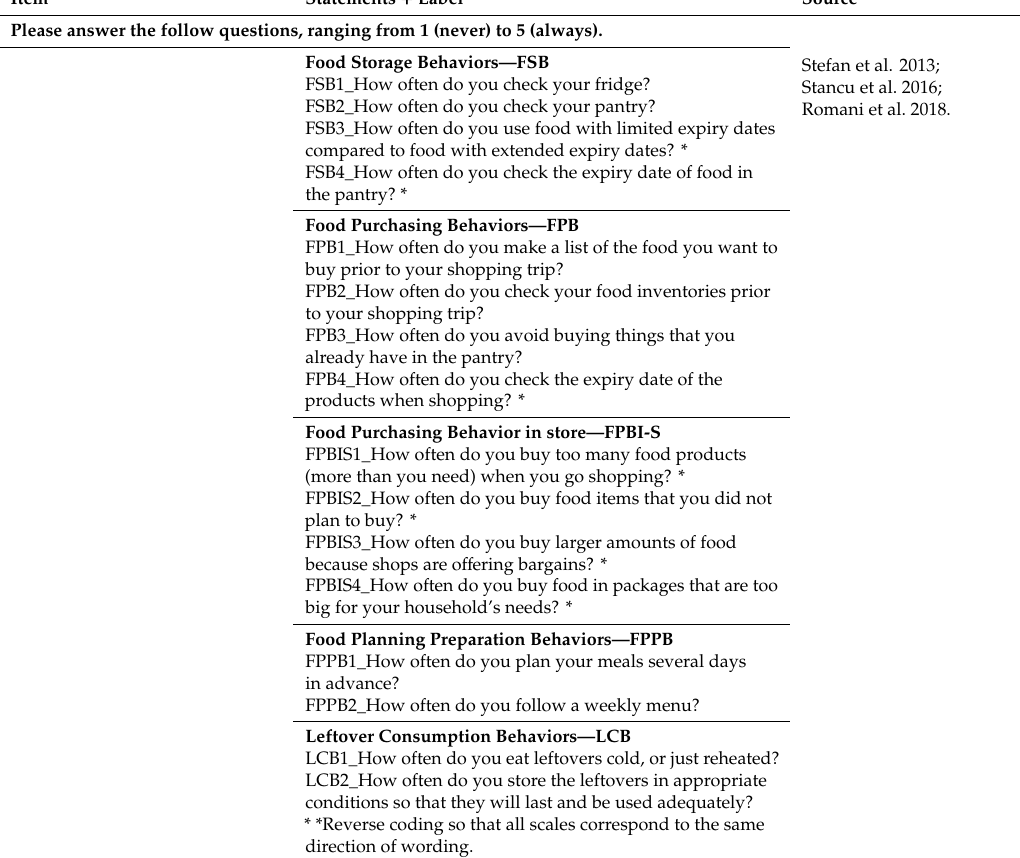
Table A1. Food management behaviors.